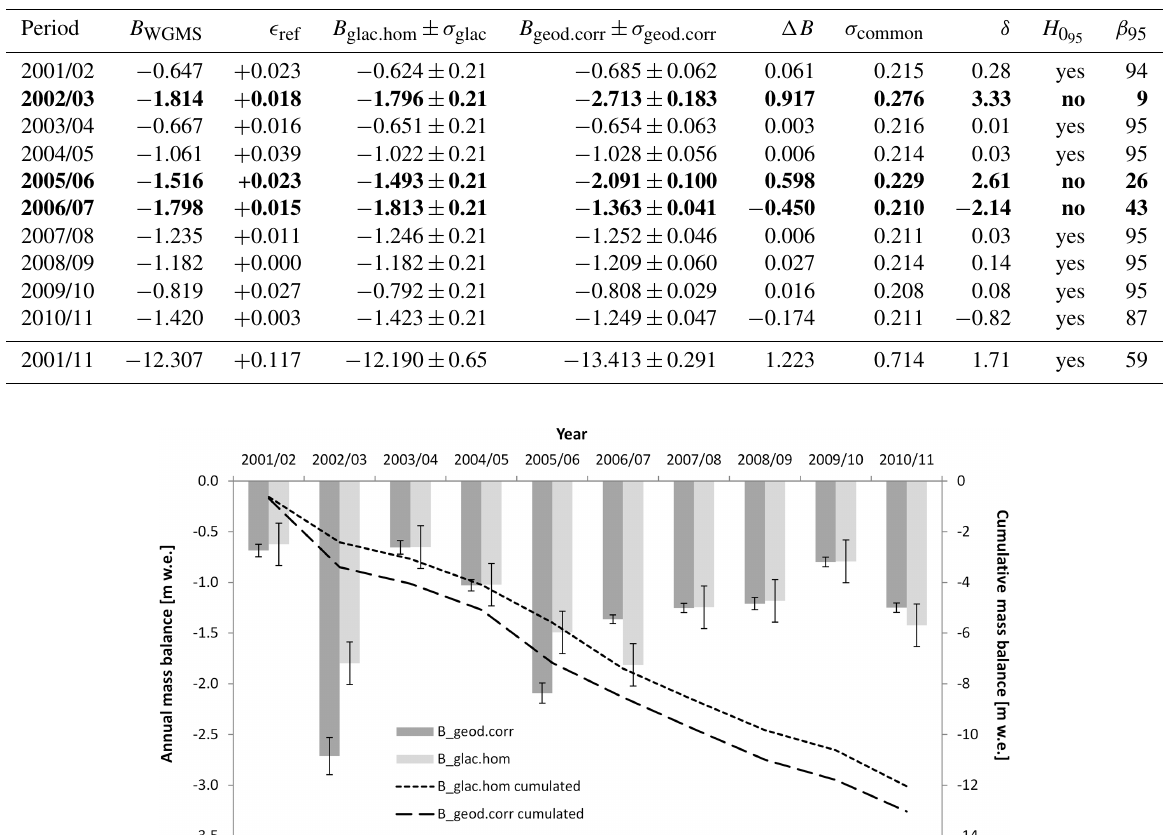
Table 2. Original glaciological mass balances ( B WGMS ), the impact of reference-area adjustment ( (cid:15) ref ), the homogenized glaciological mass balance B glac . hom with related random uncertainties σ glac , the corrected geodetic mass balances B geod . corr and their uncertainties σ geod . corr , the difference between homogenized glaciological and corrected geodetic balances (cid:49)B , the common variance of the two series σ common , and the reduced discrepancies δ . The acceptance of the null hypothesis ( H 0 ), indicating if the glaciological balance is statistically different 95 from the geodetic balance or not, is evaluated at the 95% confidence level, which corresponds to δ values inside (outside) the ± 1.96 range. β 95 depicts the probability of fulfilling H 0 is in spite of differences at the 95% confidence level. Bold entries refer to years in which H 0 95 95 not fulfilled.